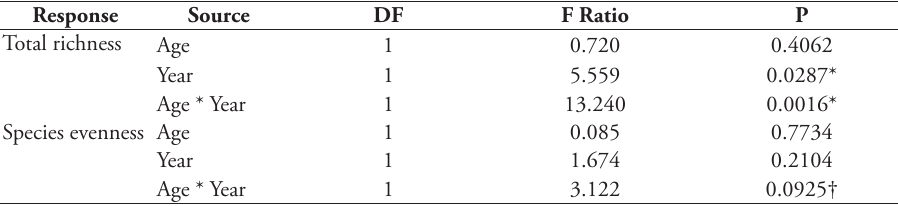
Table 1. Results of mixed-model ANOVAs explaining pond-scale total species richness and species even- ness between two time periods (1982, 2010/2011) and two categorical age groups of ponds (young, old). Pond was included as a random